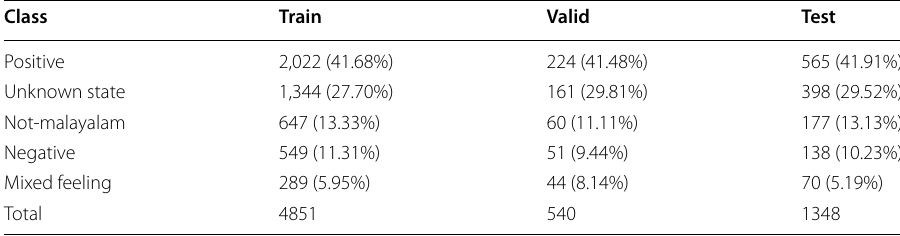
Table 2 SA data statistics